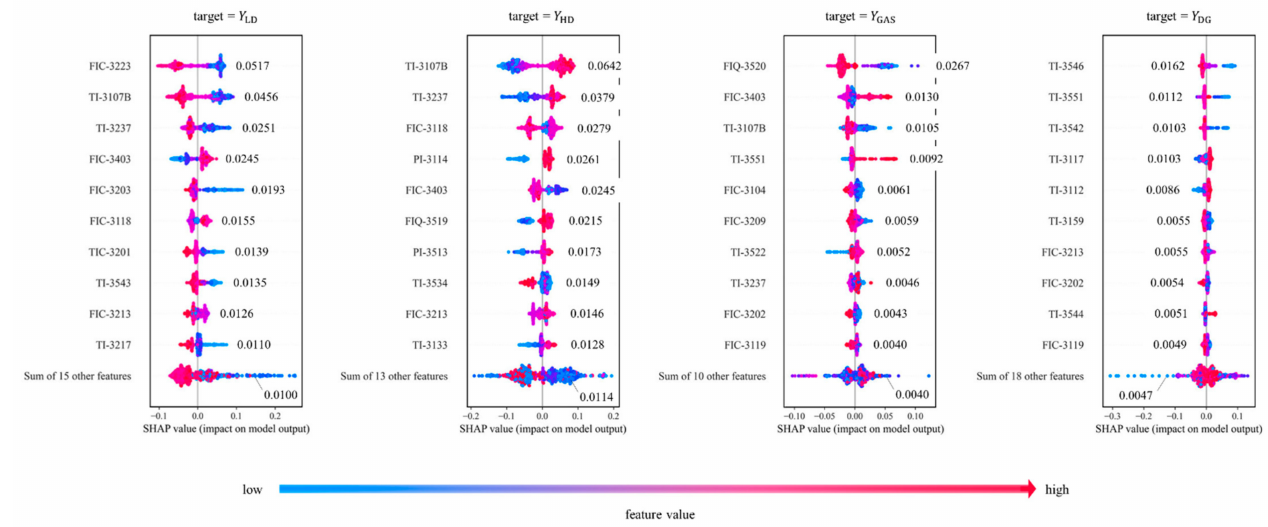
Figure 11. Summary plots and importance scores of the compact variables identified by